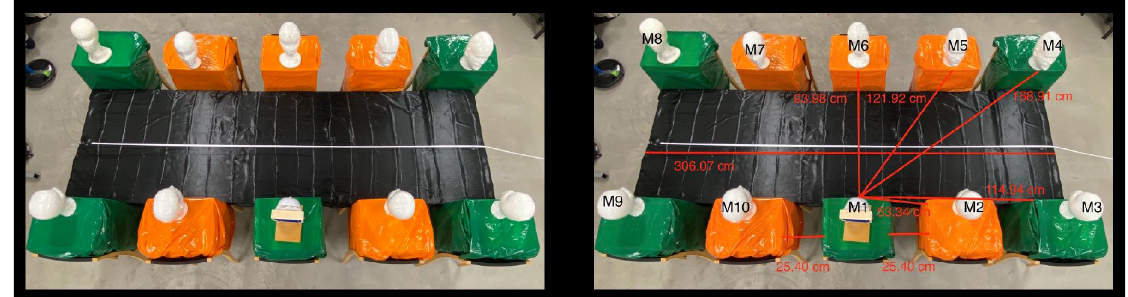
Fig 5. Measurements of normal seating positions. A white metric measuring tape with centimeter and millimeter markings can be seen in each figure. (A) A bird’s eye view photo of 10 mannequins seated in normal positions at a table can be seen. These seating positions were designed to mimic students sitting at a cafeteria table without safety protocols. (B) All mannequins are labeled as well as the measurements of the distances from the mouth of M1 to the bodies of M2, M3, M4, M5, and M6. The shoulder-to-shoulder distance between M1 to M2 as well as M1 to M10 is displayed. The length of the table is also